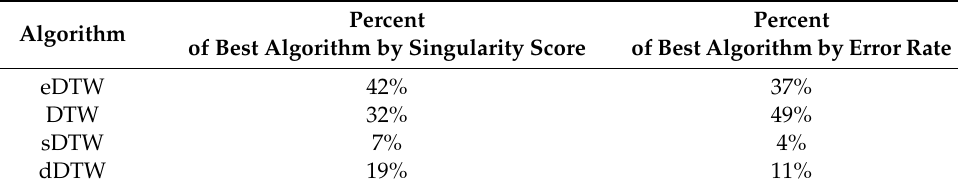
Table 1. Algorithm performances in the UCR Time Series Classification Archive.